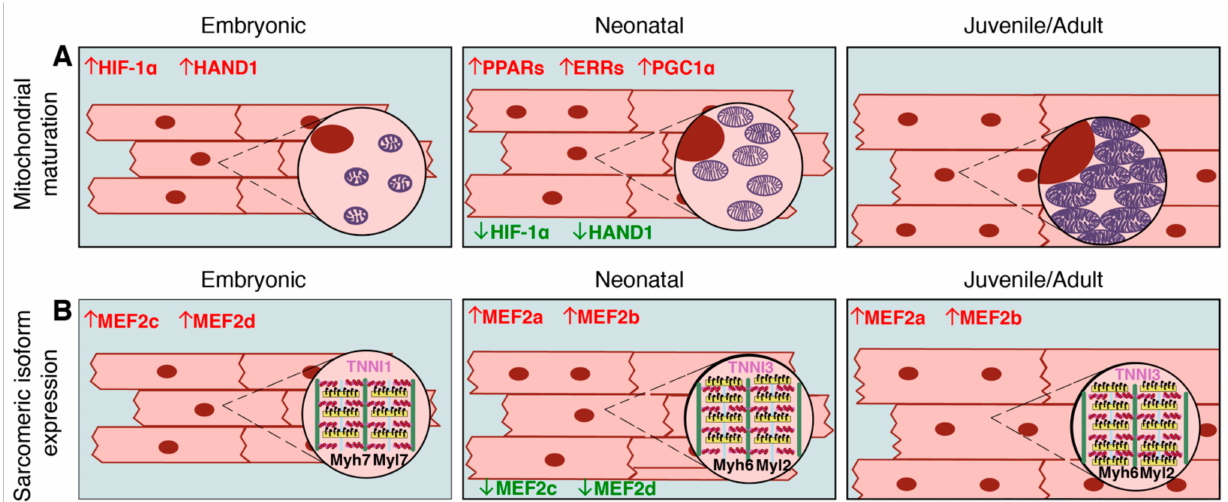
Figure 2. Transcriptional control of mitochondrial maturation and sarcomeric protein isoform expression in embryonic, neonatal, and juvenile/adult rodent cardiomyocytes. ( A ) As cardiomyocytes mature, mitochondria number and size increase, as does the number of cristae. These maturational changes are associated with downregulation (green) of embryonic transcription factors including Hif-1 α and Hand1, and upregulation (red) of neonatal/adult transcription factors including PPARs, ERRs, and PGC1 α . ( B ) Embryonic cardiomyocytes express immature Tnni1, Myh7, and Myl7, which are replaced by Tnni3, Myh6 and Myl2 during the postnatal period. Sarcomere number also increases during postnatal maturation and hypertrophic growth. This isoform switching during maturation is associated with downregulation of transcription factors, such as Mef2c and Mef2d, and upregulation of Mef2a and Mef2b. Refer to text for